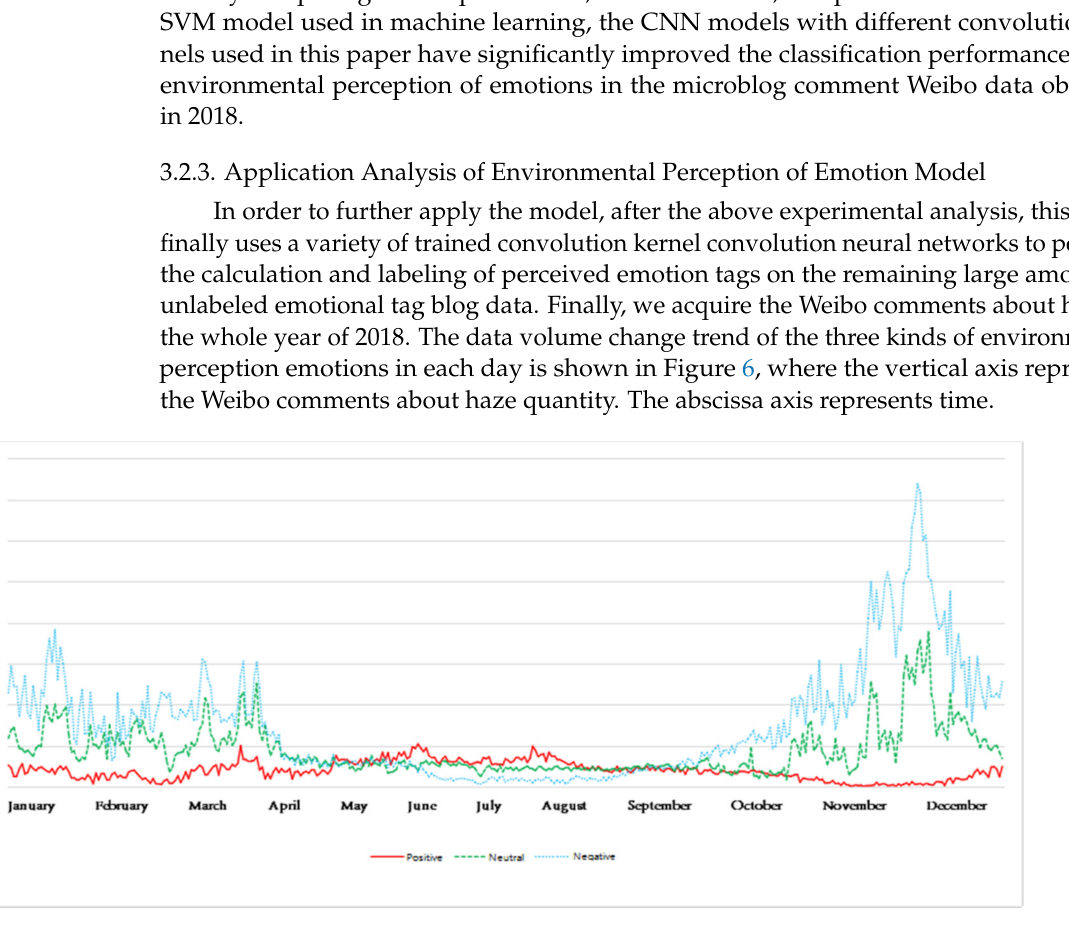
Figure 6. Change graph of environmental